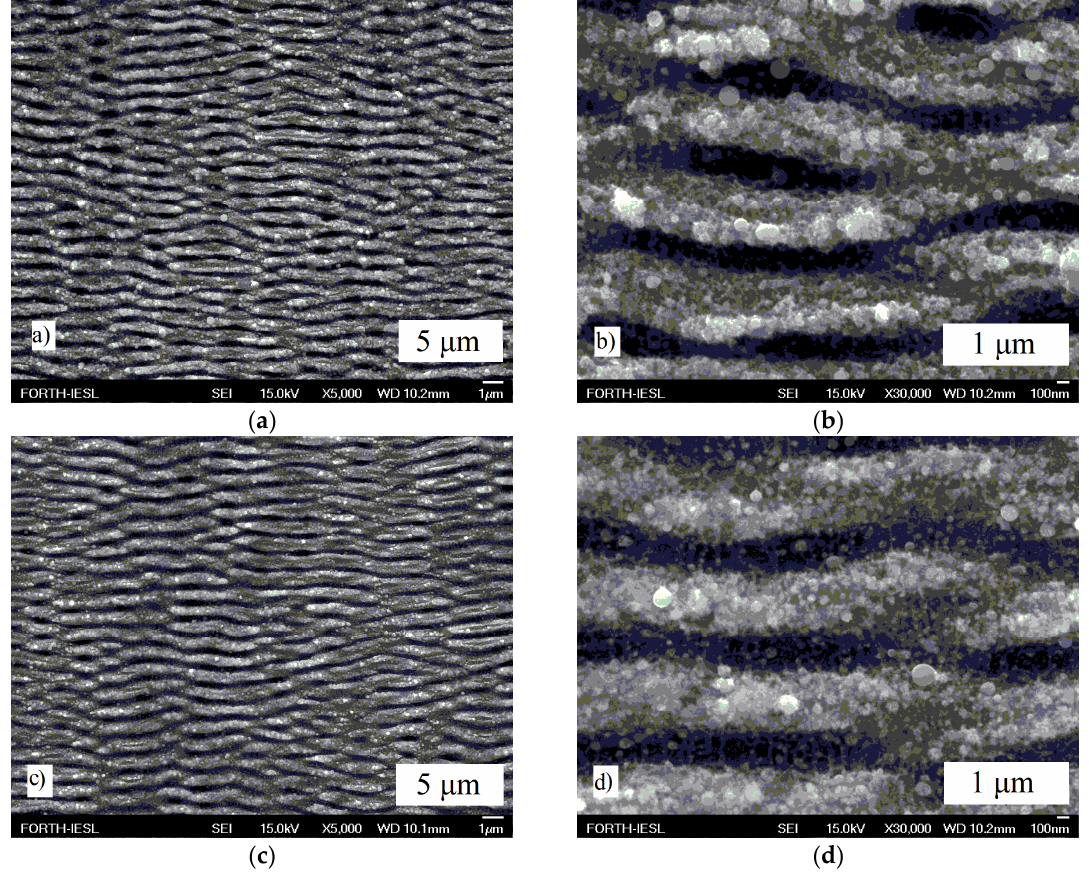
Figure 1. SEM micrographs of LIPSS on the surface of the: ( a ) 15×(Ti/Zr) on Si, magnification 5000×; ( b ) 15×(Ti/Zr) on Si, magnification 30,000×; ( c ) 8×(Zr/Cr/Ti) on Si, magnification 5000×; ( d ) 8×(Zr/Cr/Ti) on Si, magnification 30,000×.